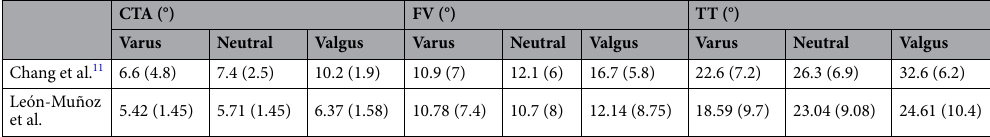
Table 4. Coronal and rotational parameters according to ethnic groups. Chang et al. 11 evaluated with CT-scan 422 cases of Asian patients with knee OA. We have evaluated 385 CT-scan based 3D virtual models of Caucasians patients with knee OA. In both studies, the patients have been divided into three groups according to the coronal alignment (HKA < 177° = varus; HKA 177° to 183° = neutral and HKA > 183° = valgus). Angular values expressed as the mean and (standard deviation). CTA condylar twist angle, FV Femoral Version measured between the femoral neck axis and the posterior condylar line, TT Tibial